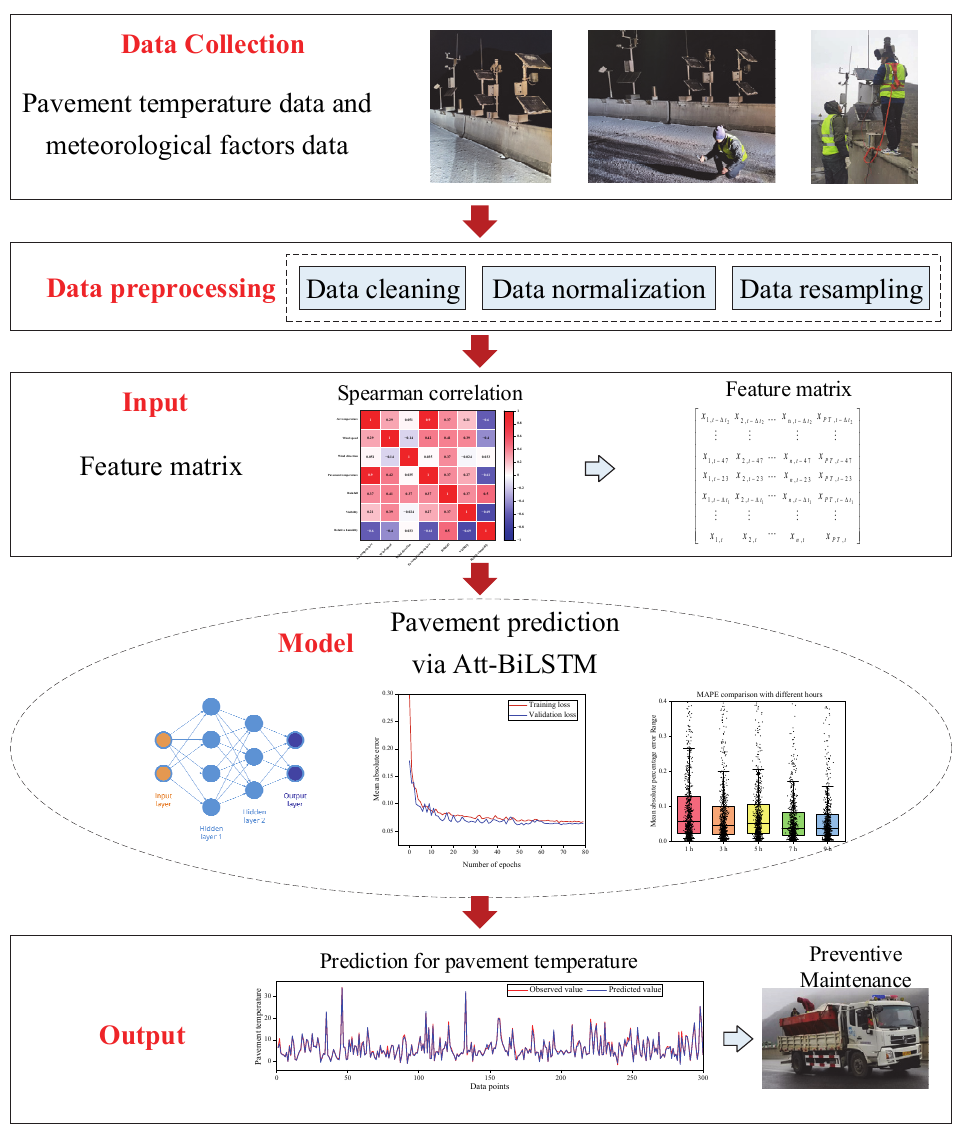
Figure 1. General outline of the research methodology.